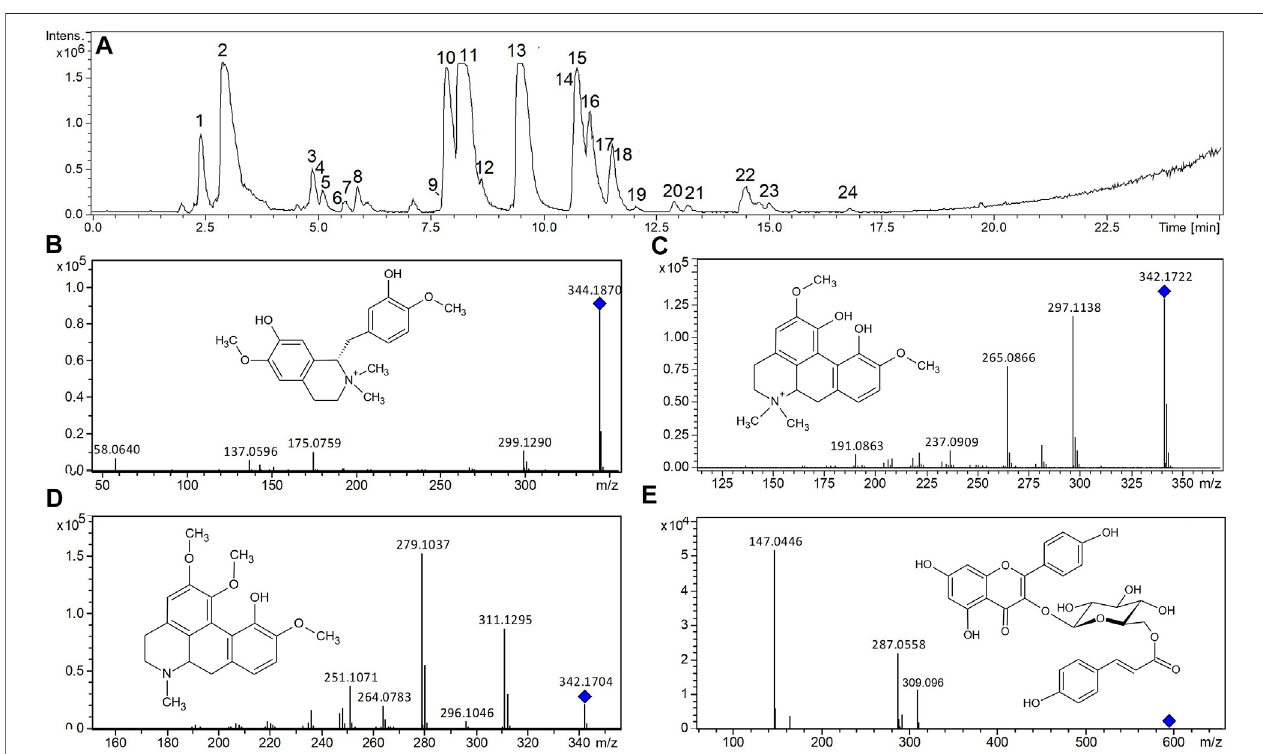
FIGURE 1 | Chromatogram ofthe ethanolic soluble fraction that was obtained from the leaves of Croton urucurana . The compounds were detected in the positive ionization mass spectrometry (A) , numbered as elution pro fi le order. (B – D) Tentative compound identi fi cation based on fragmentation pro fi le mass spectra and proposed structures of the alkaloids tembetarine (B) , magno fl orine (C) , and isocorydine (D) . (E) The mass spectrum is consistent with the proposed structure of the fl avonol-glycoside tiliroside.